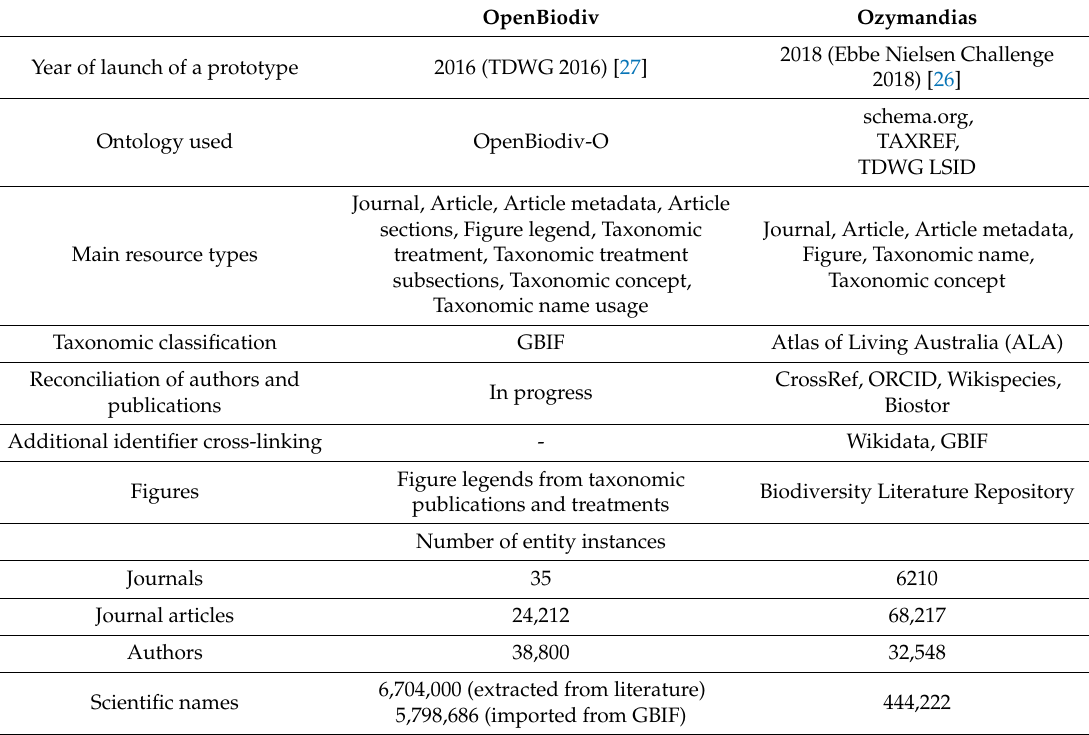
Table 2. Basic features and statistic figures of OpenBiodiv and